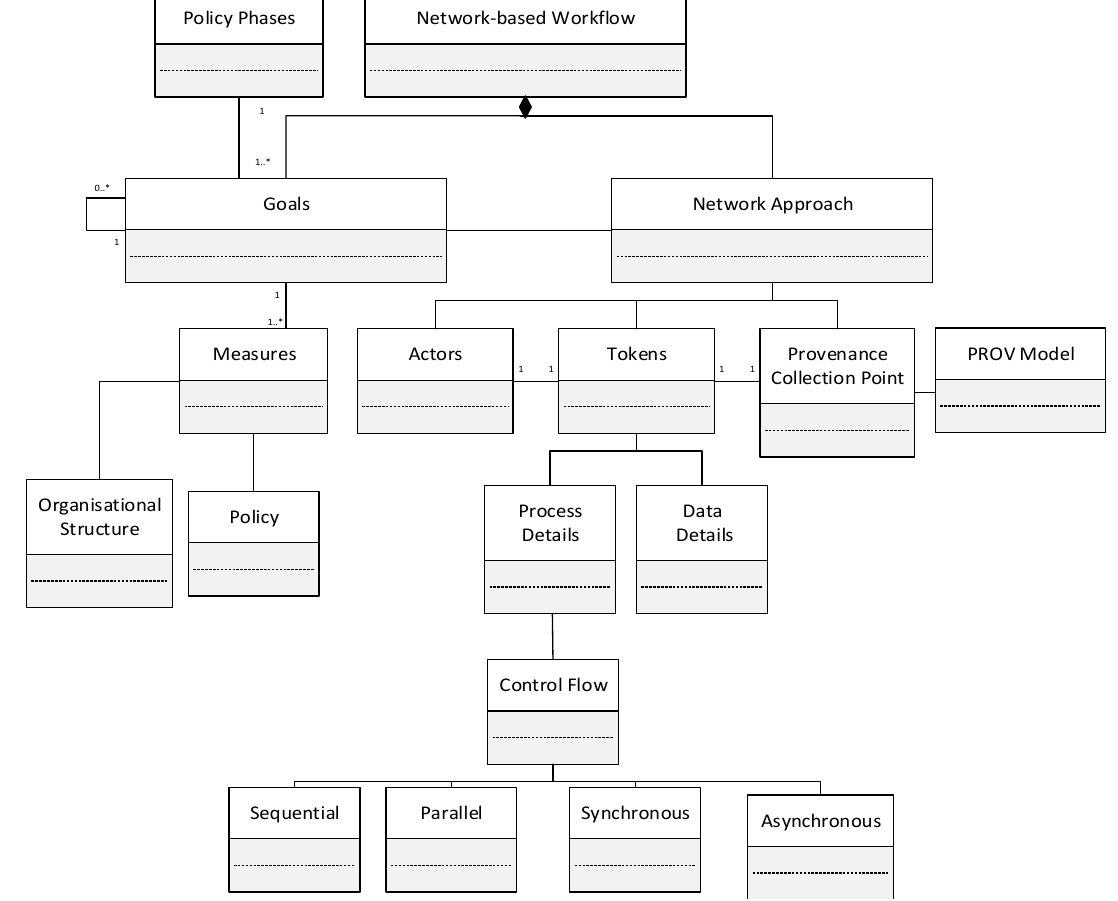
Figure 10. Conceptual model of devised approach.